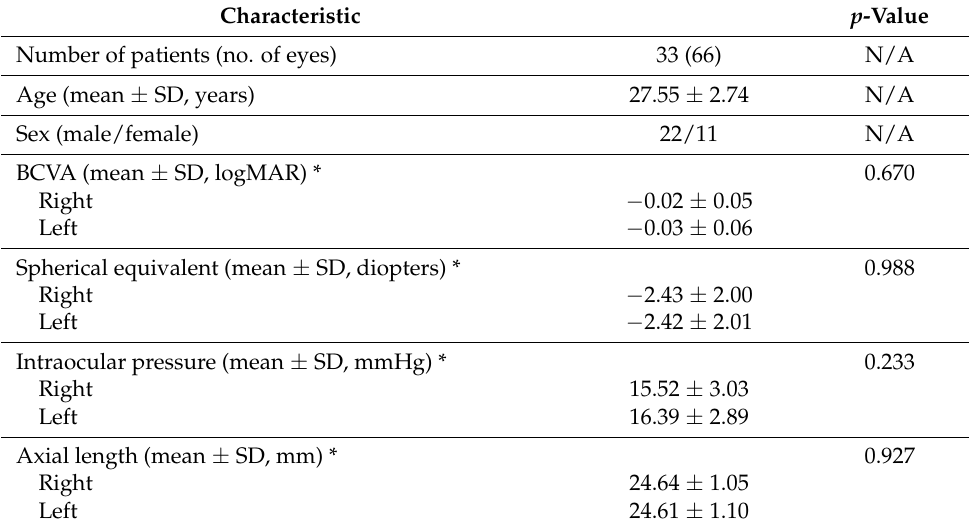
Table 1. Baseline characteristics of